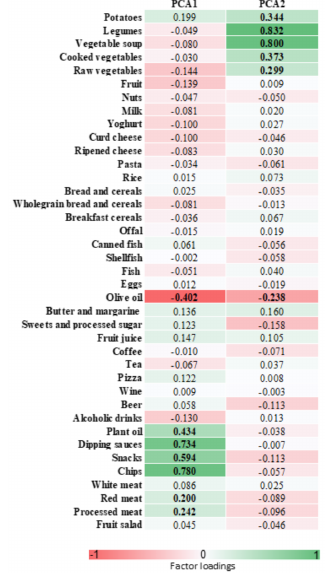
Figure 2. Table of factor loadings that characterize each dietary pattern. In red are food groups that negatively characterize dietary patterns; in green are food groups that positively characterize dietary patterns), factor loadings ≥ 0.2 are in bold font. PCA1: Western dietary pattern; PCA2: prudent dietary